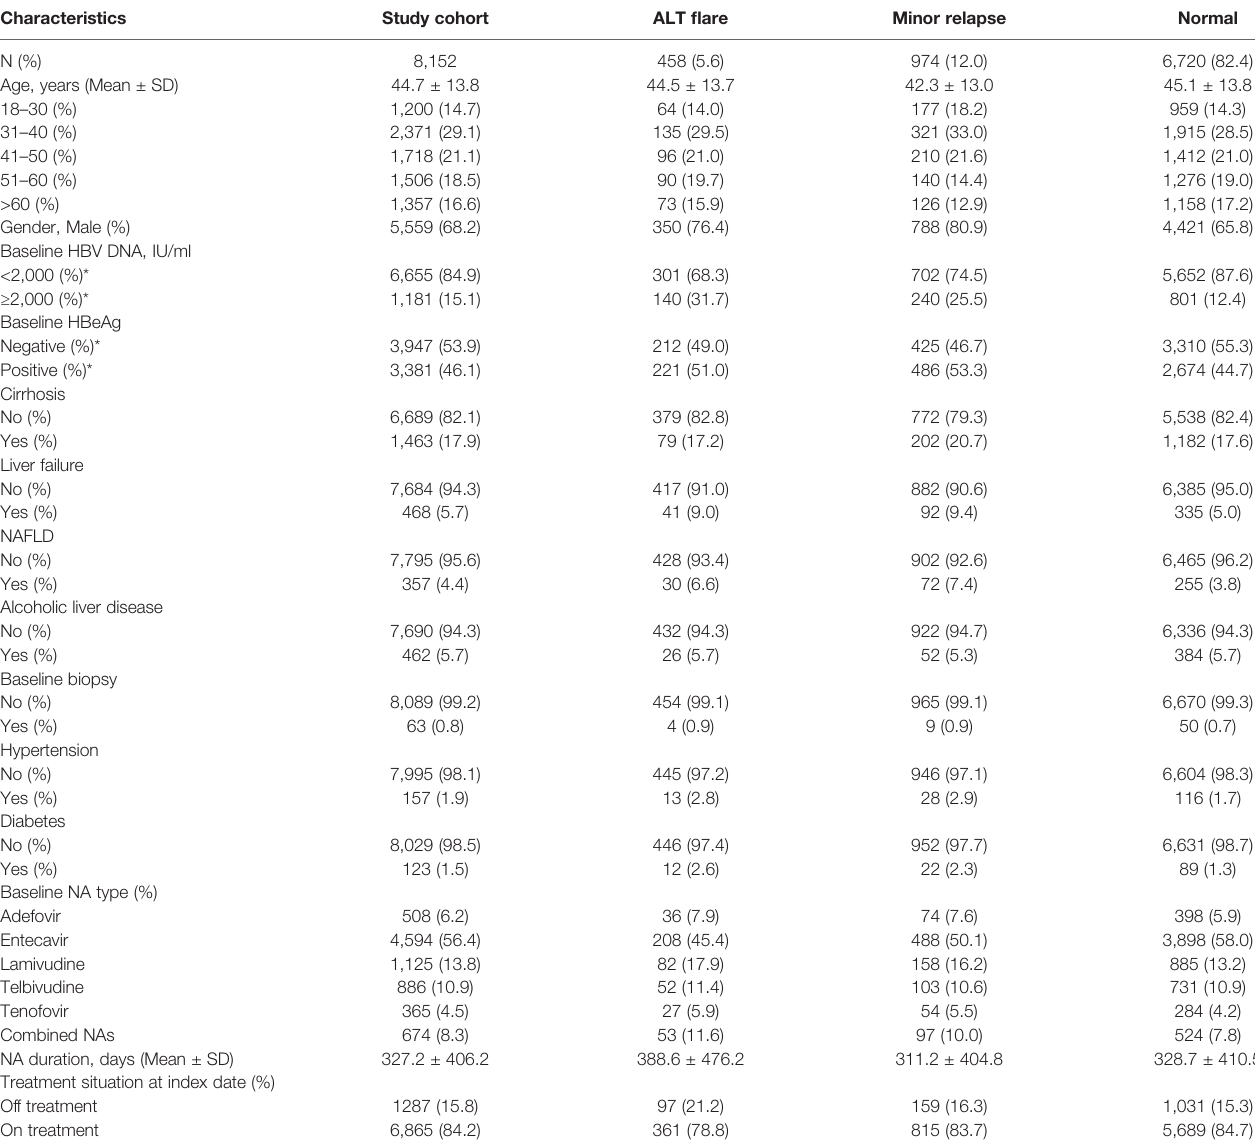
TABLE 1 | Baseline demographic and clinical characteristics of study cohort in the Ruijin Hospital, China. Characteristics Study